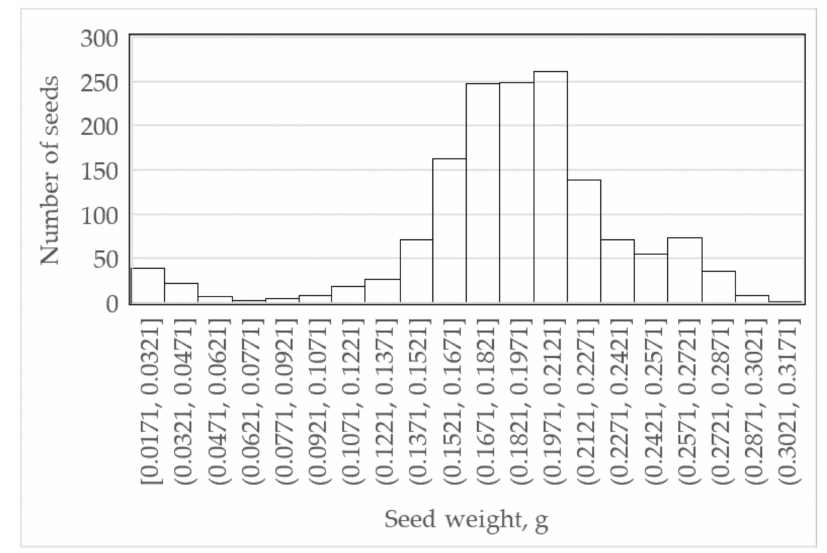
Figure 1. Histogram of individual seed